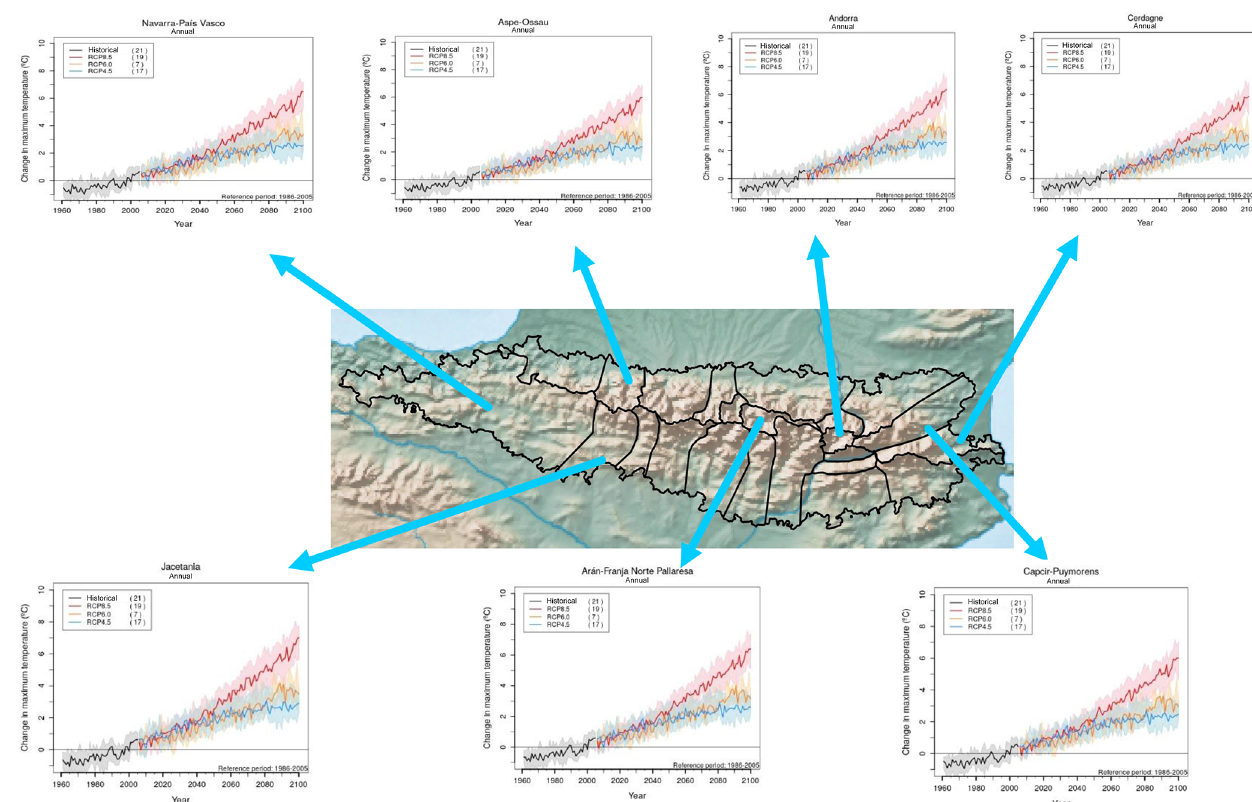
Figure 7. Evolution of downscaled maximum temperature change for seven selected massifs in the Pyrenees. Median is represented by thick line and shadow represents 17th and 83rd percentile. Number in parentheses indicates the number of models used for the corresponding emission